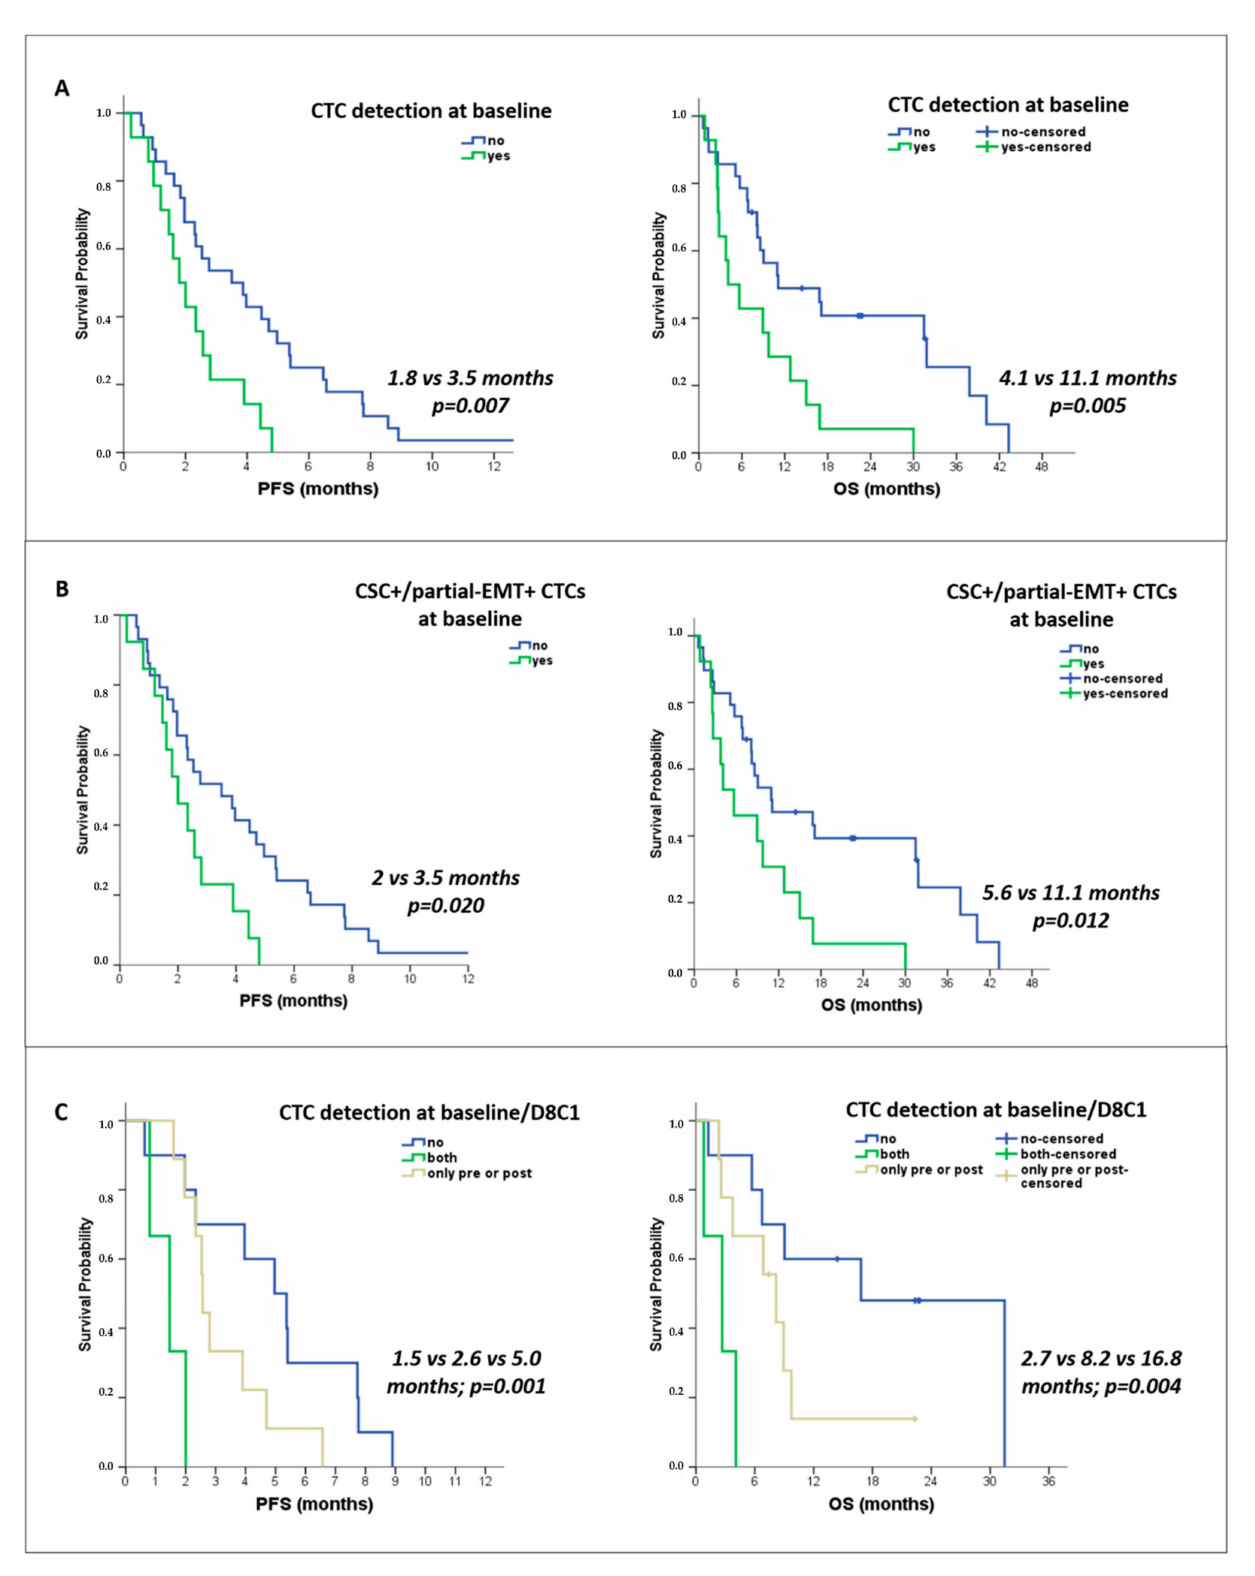
Figure 2. Correlation of the detection of CTCs and CSC/partial-EMT-like CTCs with patient out- comes. Kaplan–Meier survival curves for PFS and OS according to: ( A ) Baseline detection of CTCs ( n = 42 patients), ( B ) Baseline detection of CSC+/partial-EMT+ CTCs ( n = 42 patients), and ( C ) Com- bined CTC status at baseline and C1D8 ( n = 22